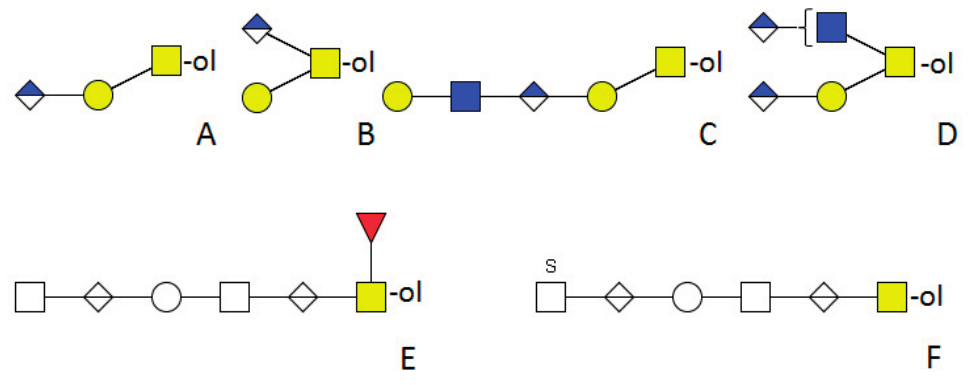
Figure 4. Examples of extended O- glycans in insects. ( A – D ) Drosophila melanogaster [41,42]; ( E , F ) were derived from a recombinant protein produced in High-Five™ cells [61]. Empty square = N -acetylhexosamine, empty circle = hexose, empty diamond = uronic acid, S =